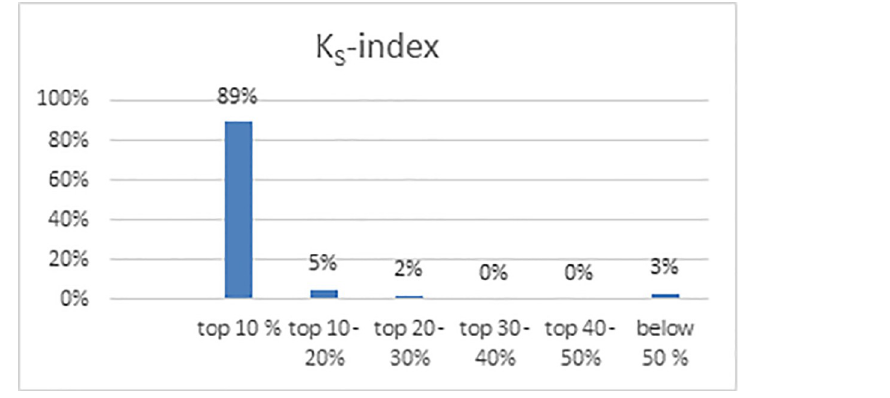
Fig 6. Occurrences of award winners in ranked list of K S